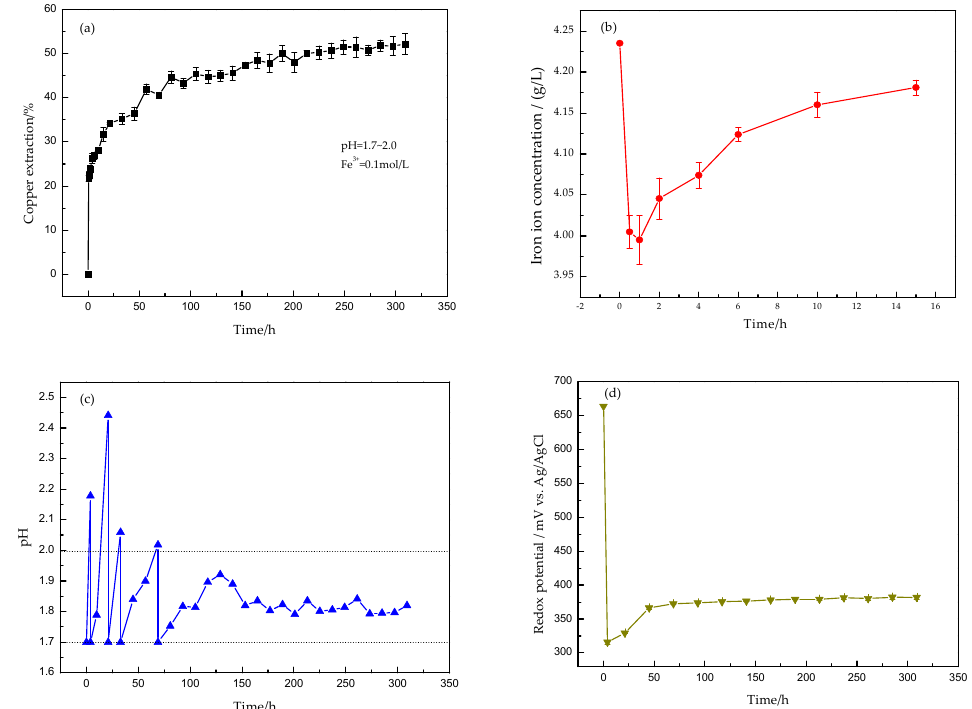
Figure 2. Results of chalcocite acidic ferric sulfate leaching (pH = 1.7~2.0, C(Fe 3+ ) = 0.1 mol/L): ( a ) Copper extraction at different leaching times; ( b ) Iron ion concentration in the first 15 h; ( c ) Variation of pH value; ( d ) Variations of redox potential.